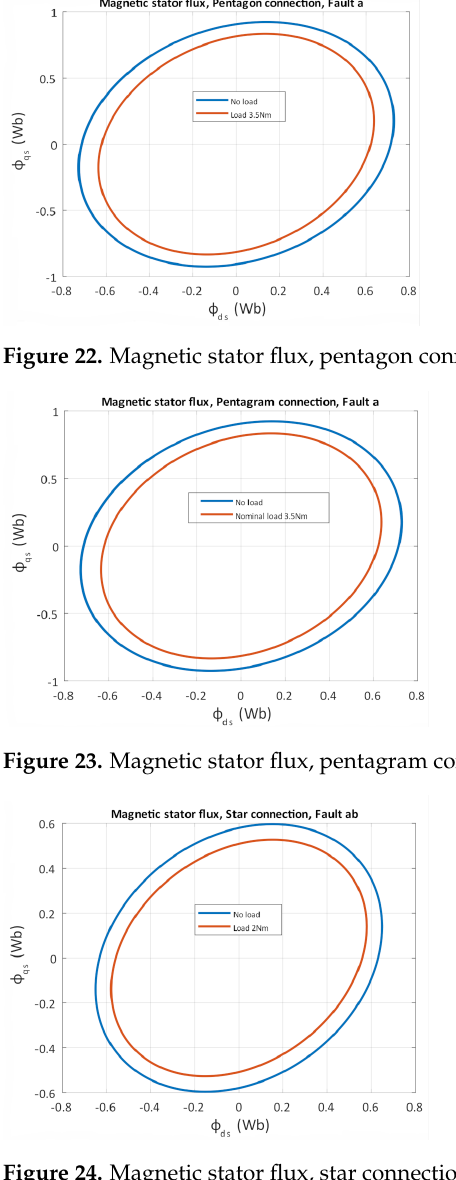
Figure 24. Magnetic stator flux, star connection, fault phase